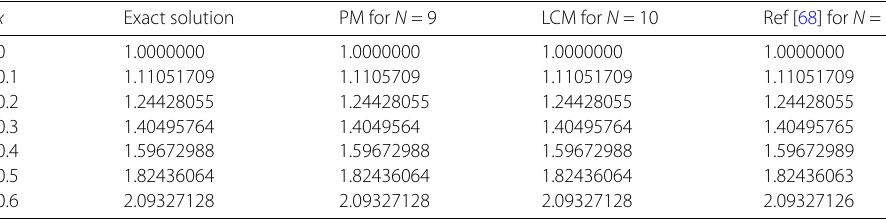
Table 5 Numerical results of Example 5 for different N values at ν 4 = 4